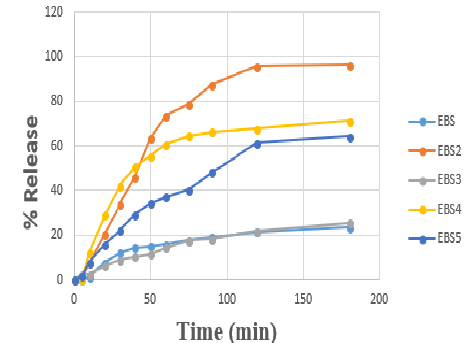
Figure 4. The release profile of pure drug and SCAs (EBS2), (EBS3), (EBS4), (EBS5) in in 0.1 N HCl at 37°C